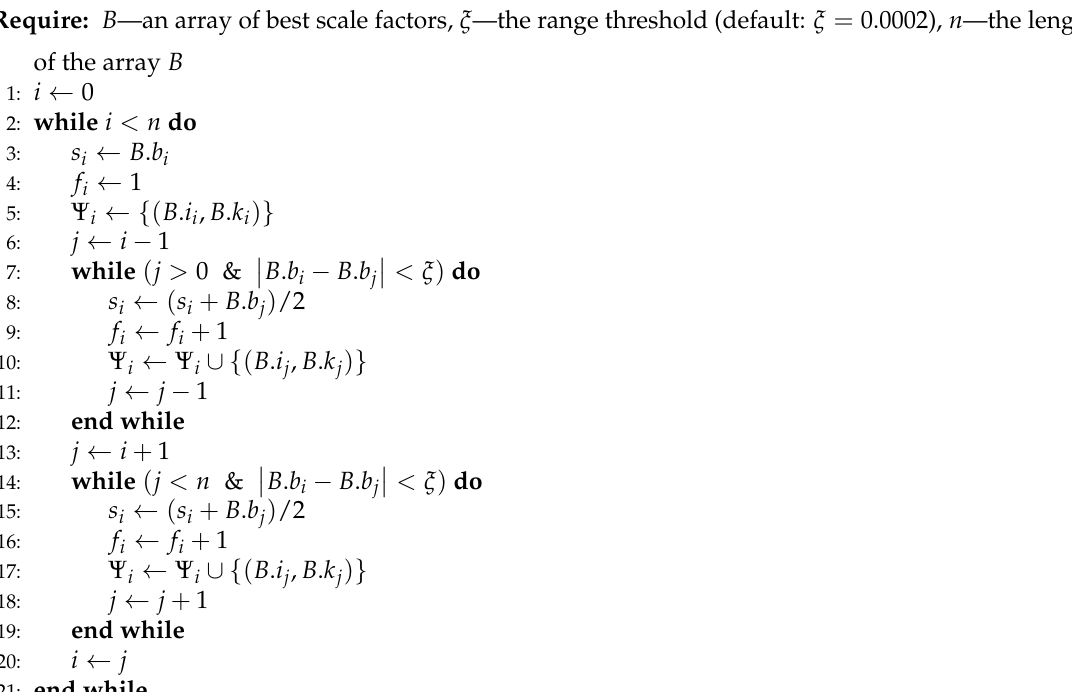
Figure 4. Determining scale factor s i and f i ; s i in an average of f i = 6 scale factors in this example. Algorithm 1 Find Most Frequent